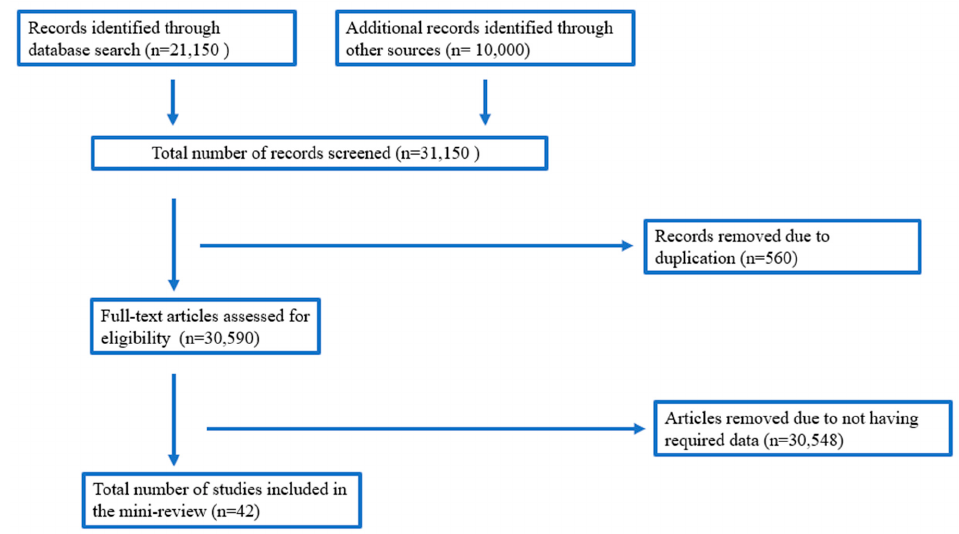
Figure 2. Diagrammatic representation of the literature search process.